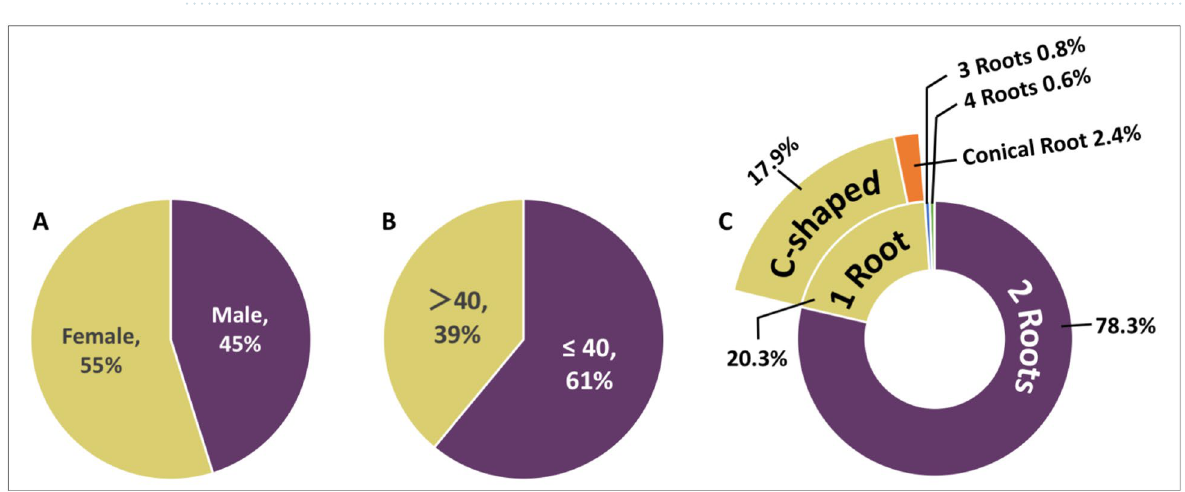
Figure 2. Pie charts showing ( A ) gender and ( B ) age data. ( C ) is a Pie chart indicating the percentage of number and morphology of roots of the studied mandibular second